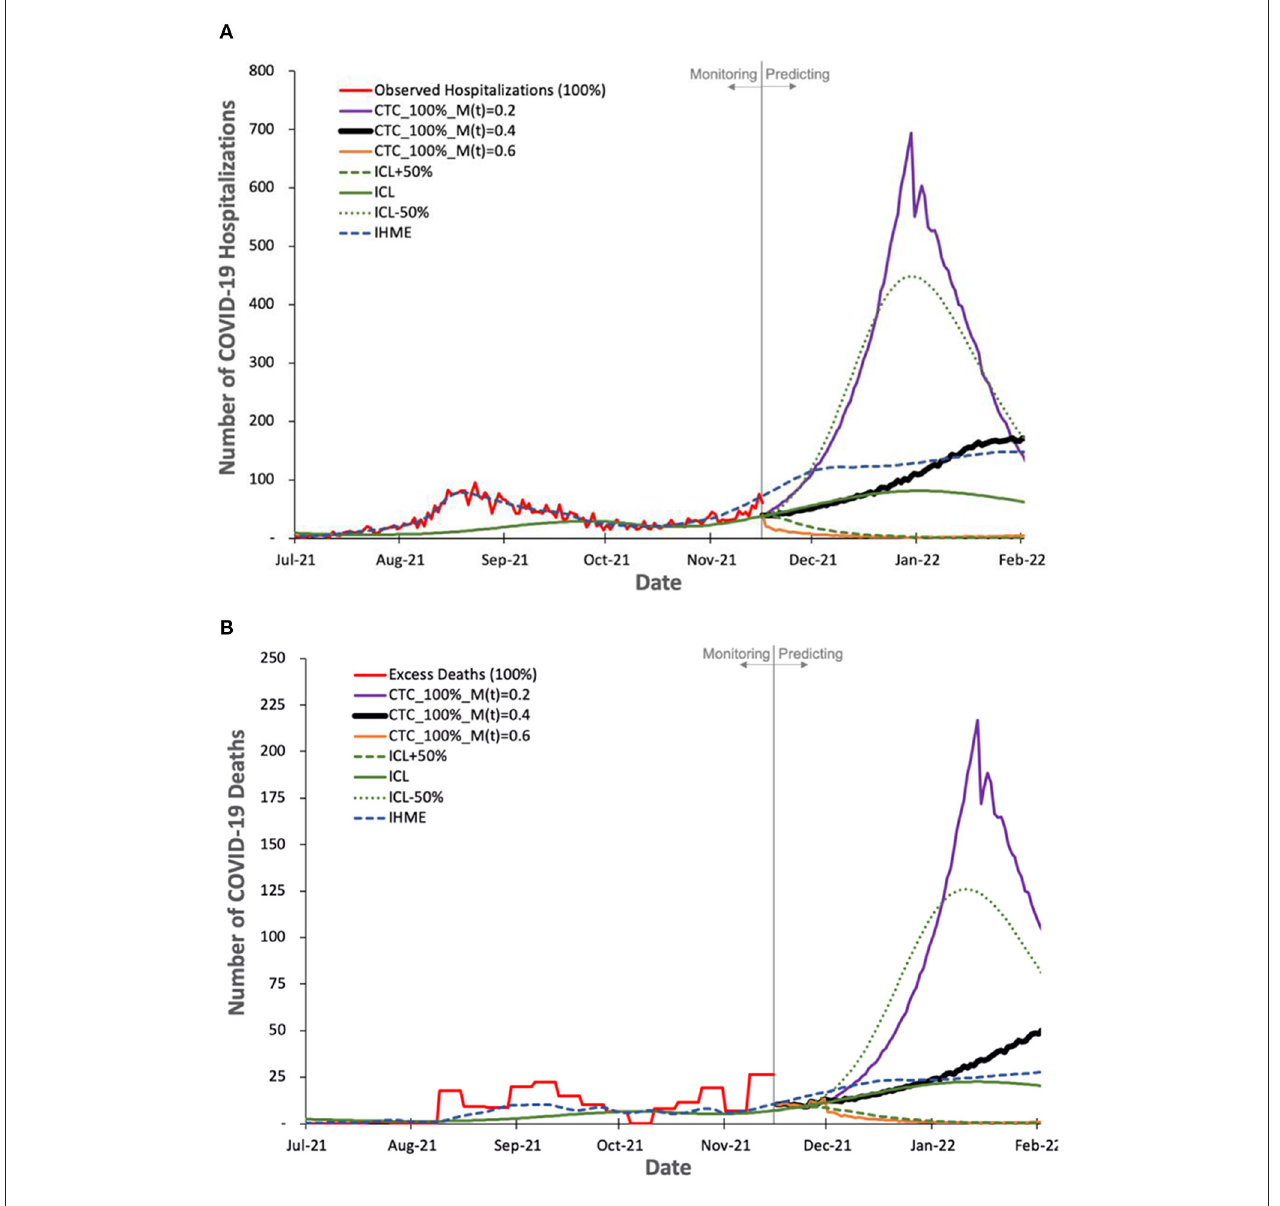
FIGURE 6 | Observed and predicted number of COVID-19 hospitalization and deaths by our model and other two state-of-the-art models, ICL and IHME. For COVIDHunter, we use a certainty rate level of 100% for the numbers of (A) hospitalizations and (B) deaths, as IHME and ICL models tend to follow such a certainty rate. We show the prediction of COVIDHunter using three mitigation coefficient, M ( t ) , values, each of which is applied from 20 November to 20 December 2021. The predicted plot in a bold black line represents the situation when the mitigation measures applied before the prediction period remain the